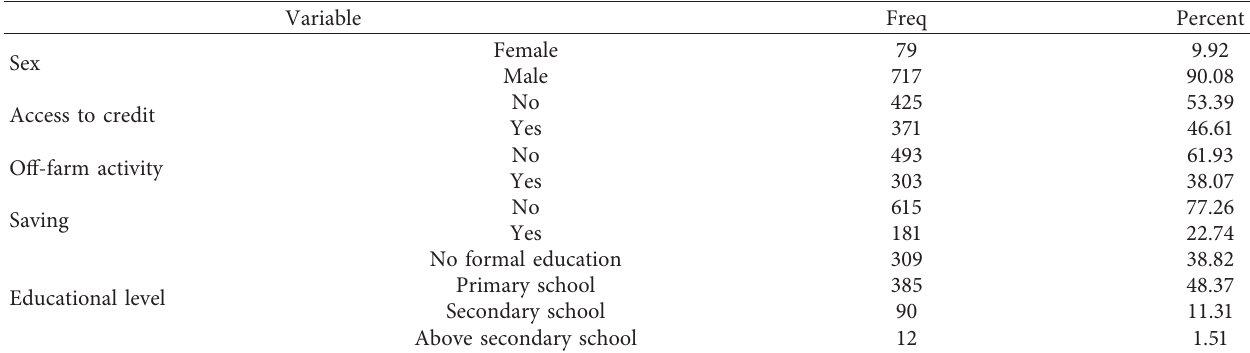
Table 3: Socioeconomic and institutional characteristics of the households.